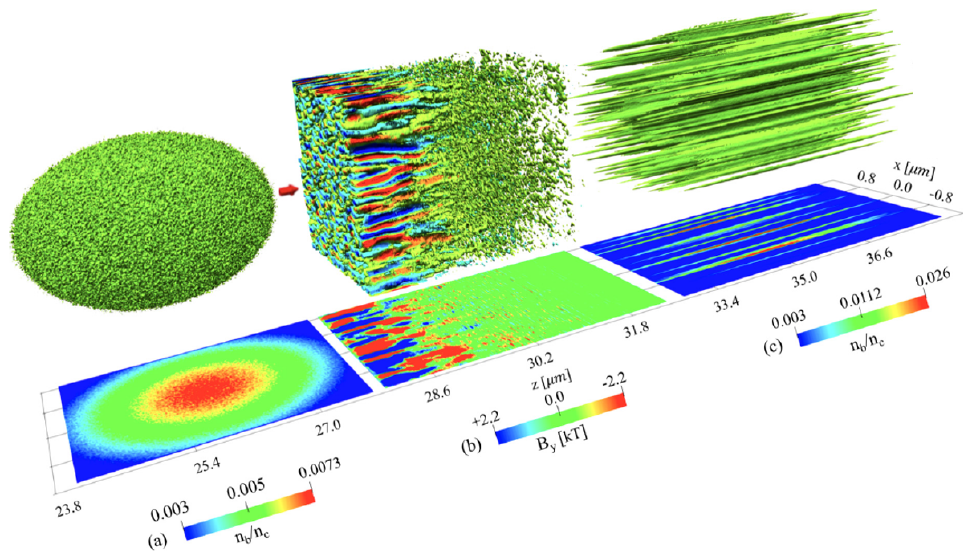
Figure 7. Laser-driven plasma instability probed by an electron beam from LWFA as a result of interaction between the laser pulse and the foil used as a laser blocker for separation of targets in LWFA → PWFA setups (figure adapted from